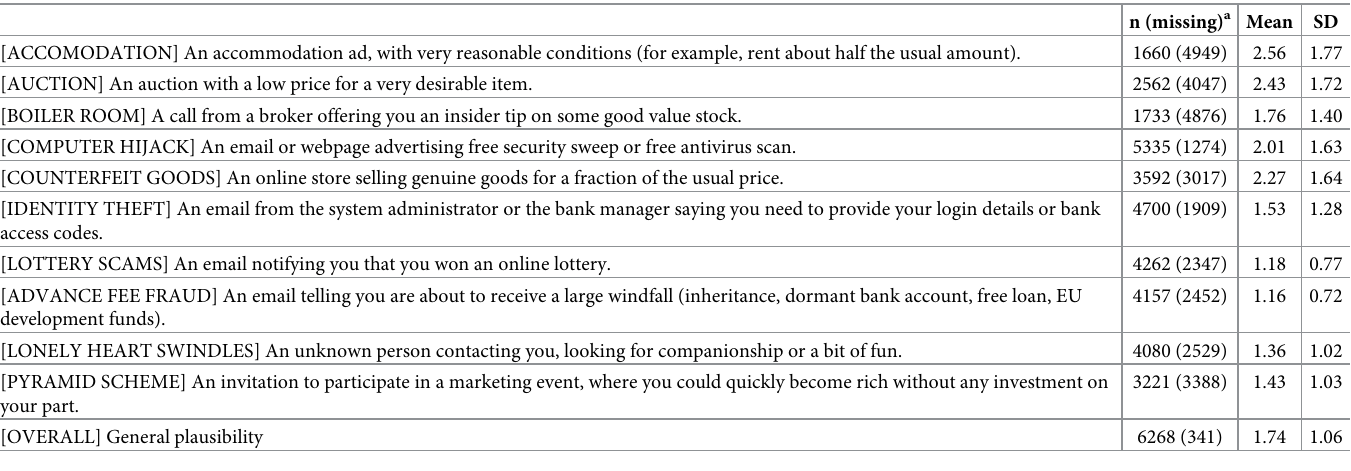
Table 4. Descriptives for overall and plausibility of individual schemes (n = 6609).